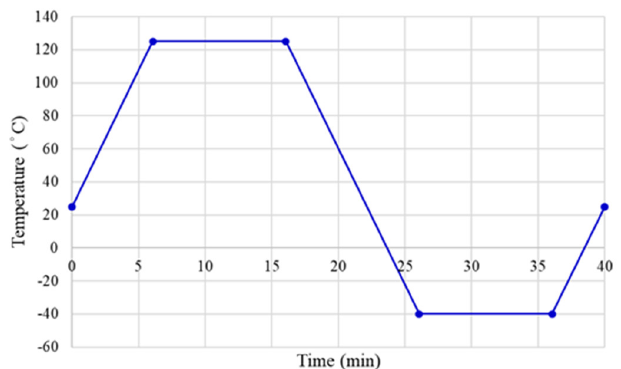
Figure 6. Thermal cycling temperature profile.